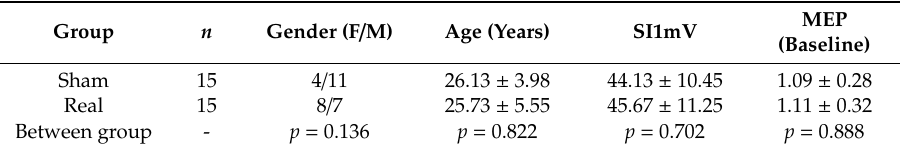
Table 1. Demographic information, SI1mV, and baseline measurements of motor-evoked potentials (MEP) amplitudes (mV) of the intervention